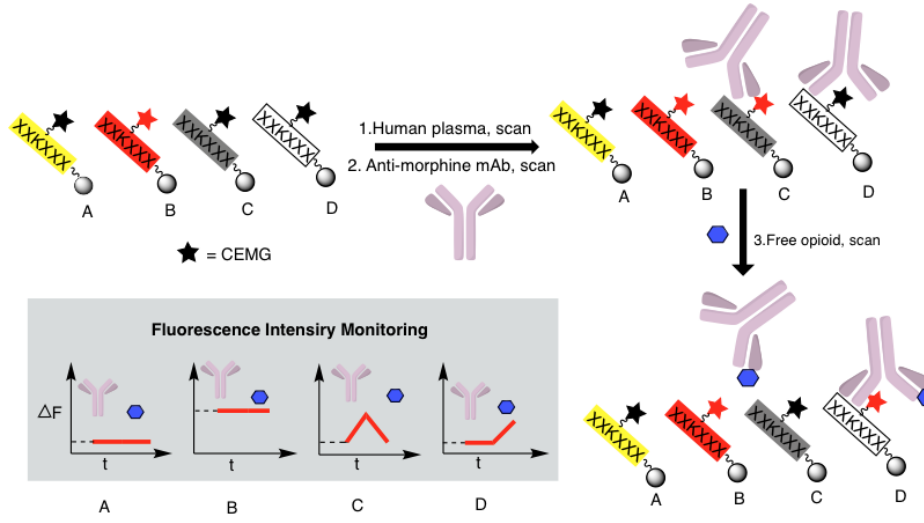
Figure 2. Three-step fluorescent screening assay of the illuminating peptide libraries.